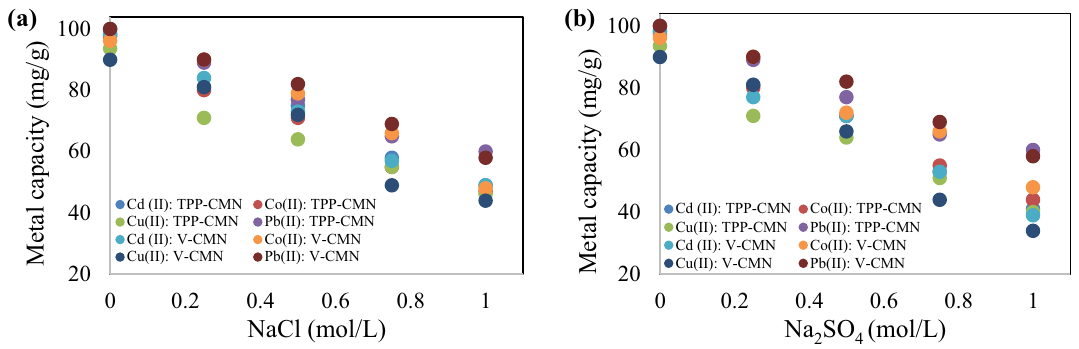
Figure 7. Effect of ionic strength on the adsorption of Cd (II), Co (II), Cu (II), and Pb (II) ions by TPP-CMN and V-CMN nano-sorbents using ( a ) NaCl and ( b ) Na 2 SO 4 .